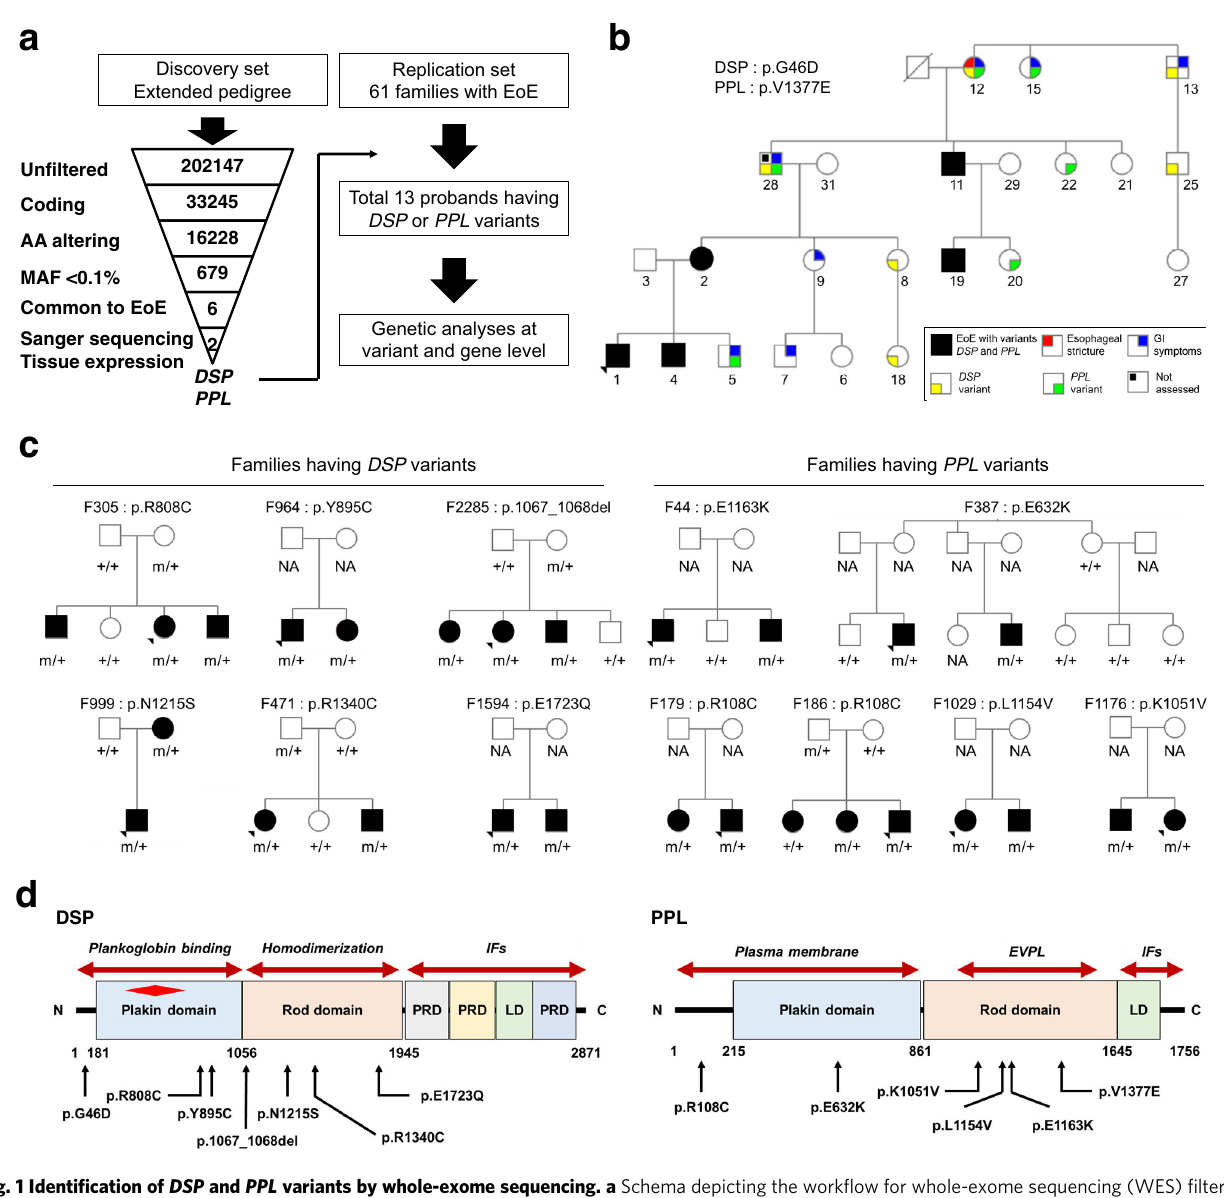
Fig. 1 Identi fi cation of DSP and PPL variants by whole-exome sequencing. a Schema depicting the work fl ow for whole-exome sequencing (WES) fi ltering of rare variants in fi ve patients with eosinophilic esophagitis (EoE) in the discovery set and con fi rmation in the replication set, as detailed in Methods. b Simpli fi ed pedigree of F430 (Details are in Supplementary Fig. 1). The arrowhead in the lower left corner indicates the proband and the slash indicates a deceased subject. “ Not assessed ” indicates the subject having GI symptoms but had never undergone an esophagogastroduodenoscopy. c Pedigrees of families with DSP or PPL variants in the replication set. Solid symbols indicate subjects with EoE, and open symbols indicate unaffected subjects. Arrowheads in the lower left corner indicate probands. For variant genotyping, “ m ” indicates the mutant DSP or PPL allele and “ + ” the reference allele. d Protein domain architectures and the location of amino acids predicted by mutations for DSP and PPL . The red diamond indicates a “ hotspot ” for mutations associated with cardiocutaneous disorders 30 . EoE eosinophilic esophagitis, DSP desmoplakin, PPL periplakin, AA amino acid, MAF minor allele frequency, GI gastrointestinal, NA not assessed, DSC1 desmocollin 1, JUP junction plakoglobin, PKP1 plakophilin 1, IFs intermediate fi laments, EVPL envoplakin, PRD plakin repeat domain, LD linker